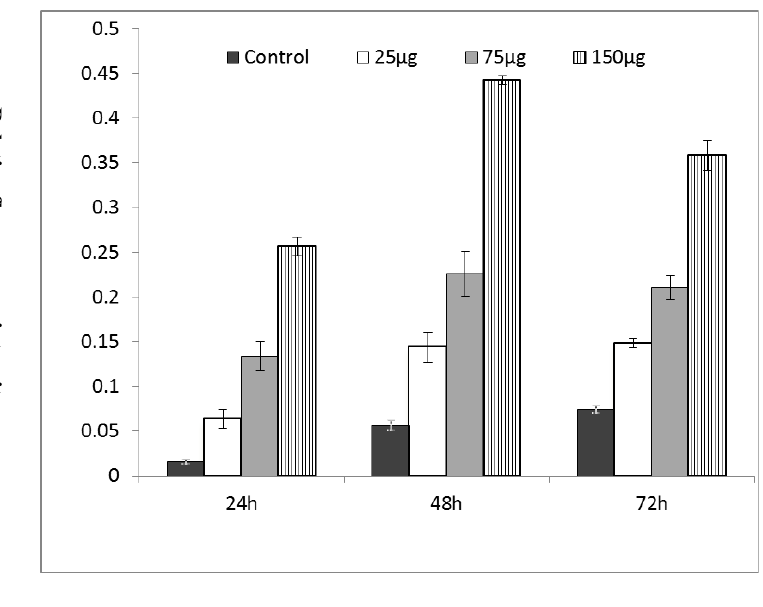
Figure 5. Analysis of gene expression of GST genes of each cell line by fluorometric determination. Fluorometric results showed that the gene expression of the cell line (HepG2), which depends on the MgO concentration and incubation times. Molecular beacons targeting the GST gene were delivered into live cells by a reverse permeabilization method using an activated SLO. The GST gene was expressed maximum at 48 h incubation time with proportion to MgO